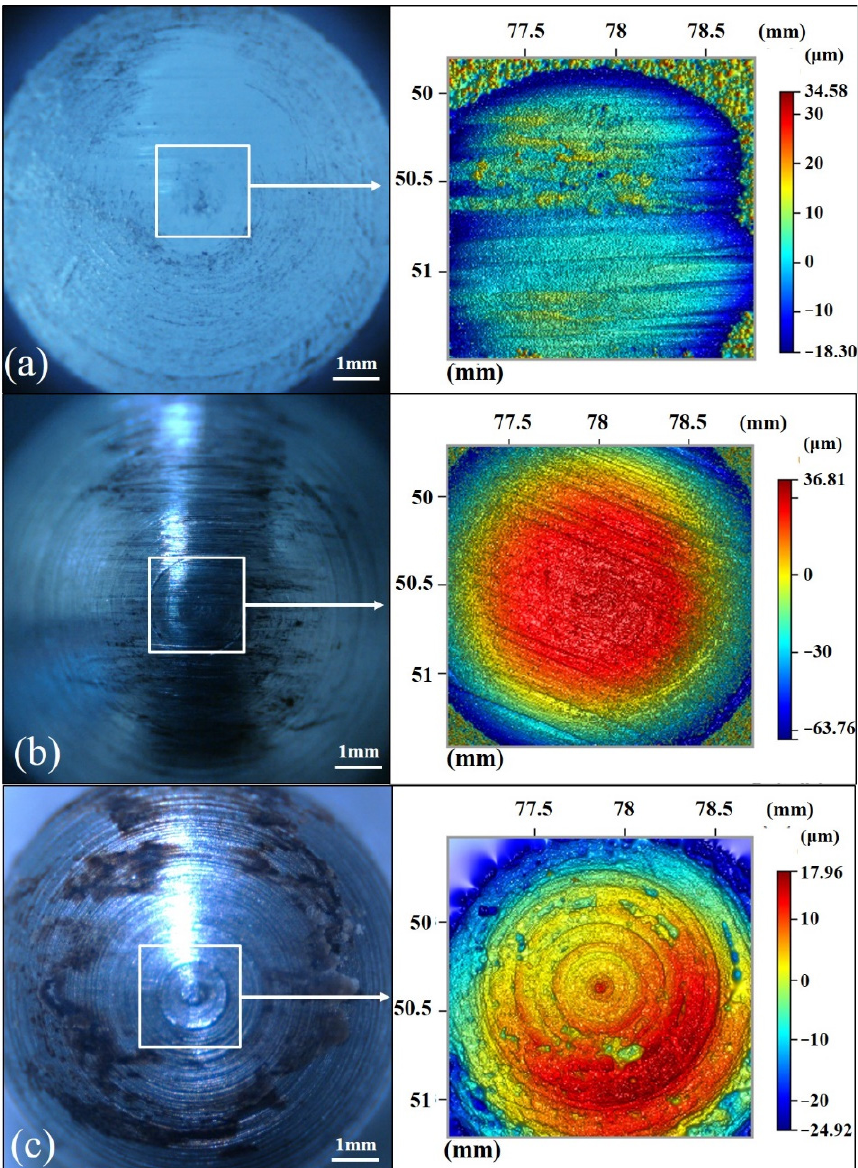
Figure 5. Changes in the coefficient of friction depending on different materials of pin specimens.